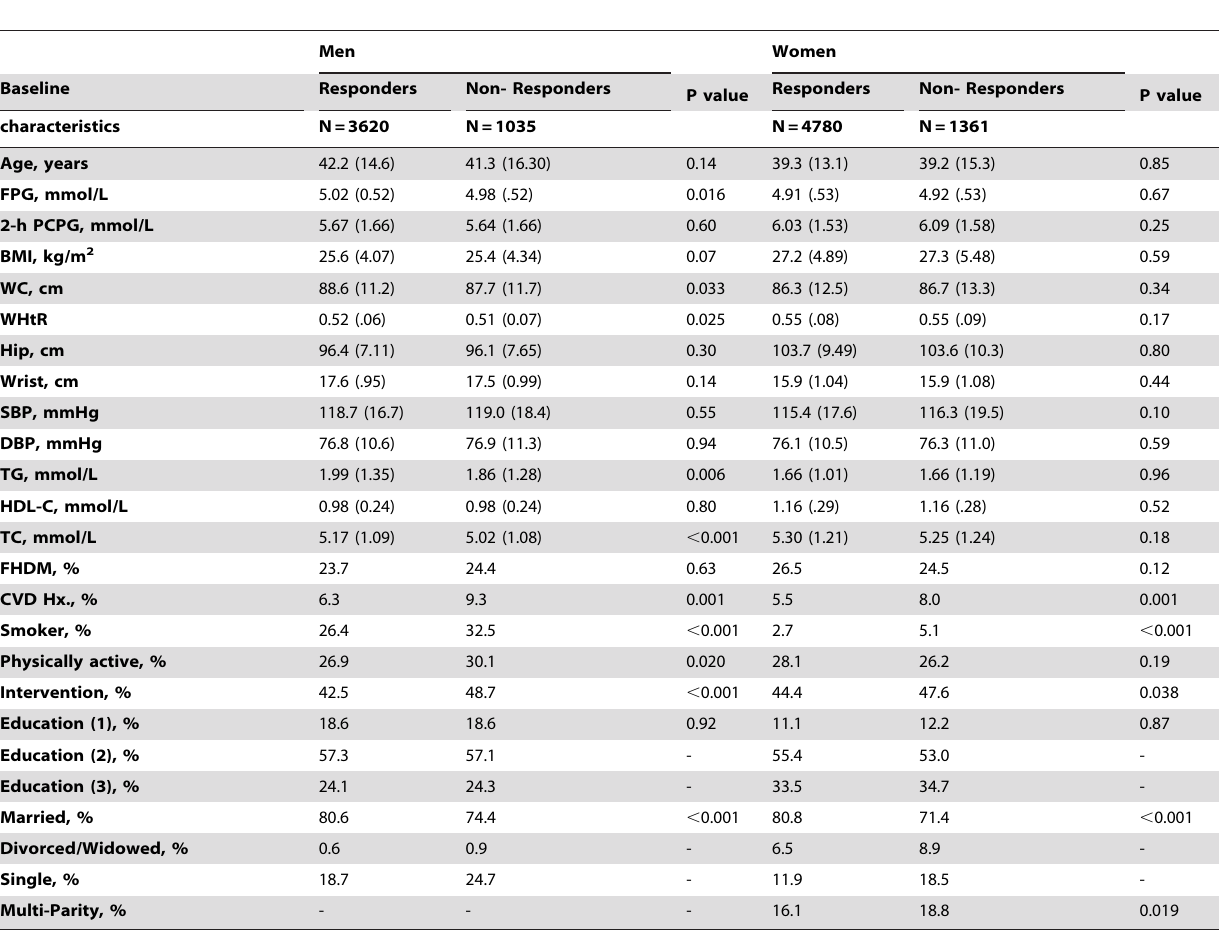
Table 1. Baseline characteristics of study participants and non-responders (those without follow-up data). Tehran Lipid and Glucose Study